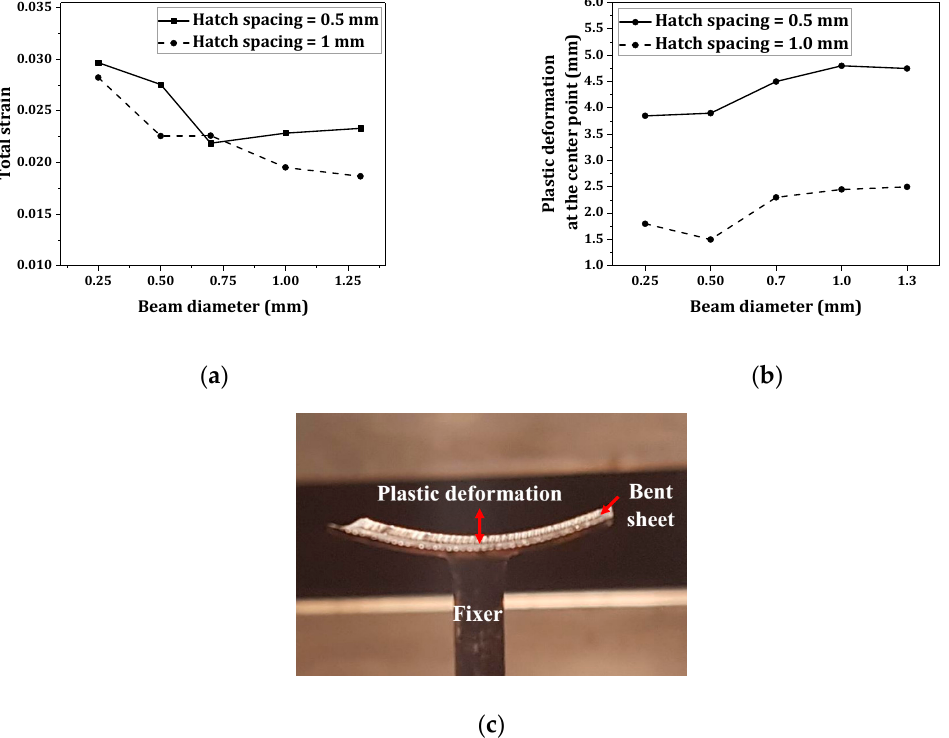
Figure 6. ( a ) Total strain; ( b ) plastic deformation at the center point from the experimental measurements; and the ( c ) deformed sample.